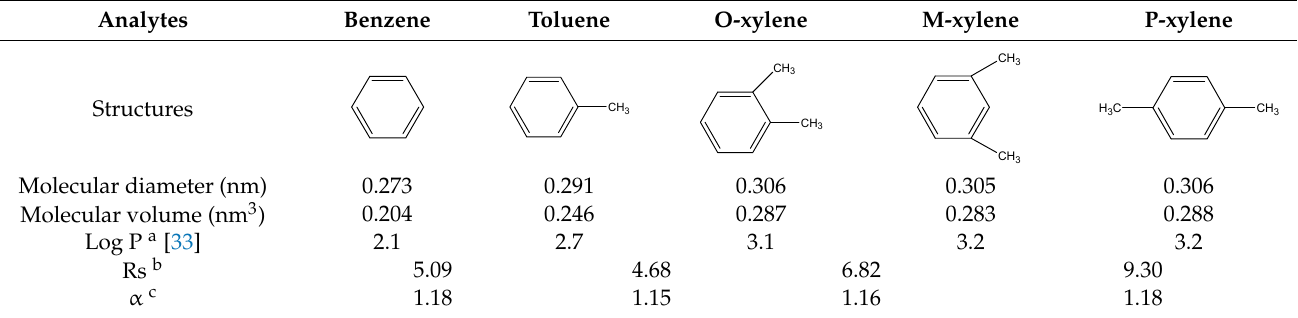
Table 2. Basic information, resolution (Rs) and separation coefficient ( α ) of the alkyl benzenes. Analytes